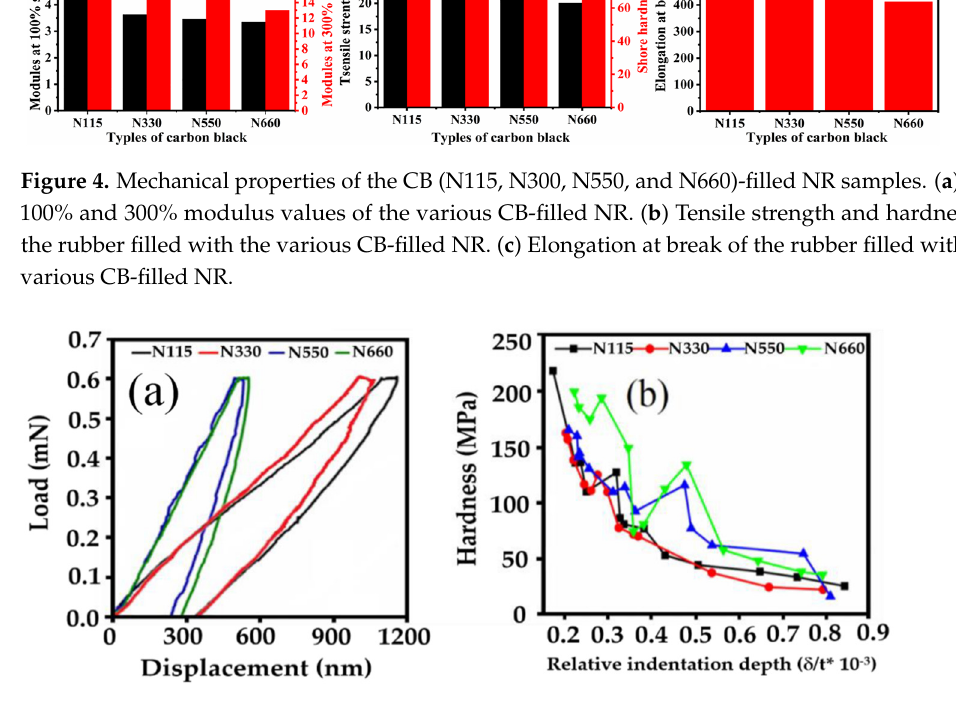
Figure 5. ( a ) Typical force–displacement curves for CB/NR. ( b ) Variation in the hardness of the four different CB/NR composites with relative indentation depth.